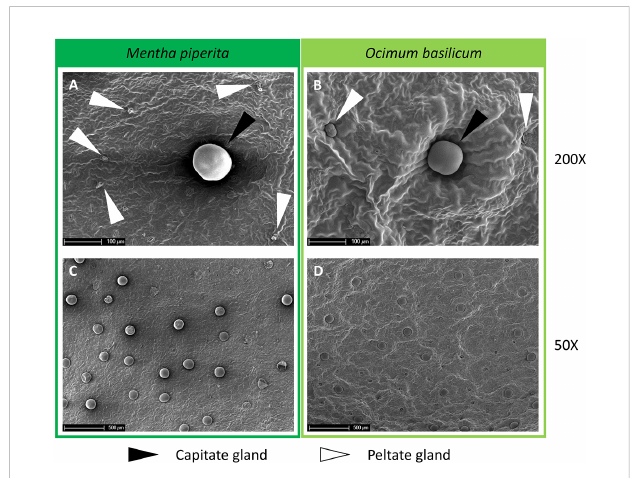
FIGURE 4 (A, B) SEM images at 200X magni fi cation and (C, D) 50X magni fi cation of the abaxial side of Mentha piperita (dark green) and Ocimum basilicum (light green) leaves. In panels (A , B) , capitate glands are marked with black arrows while peltate glands are marked with white